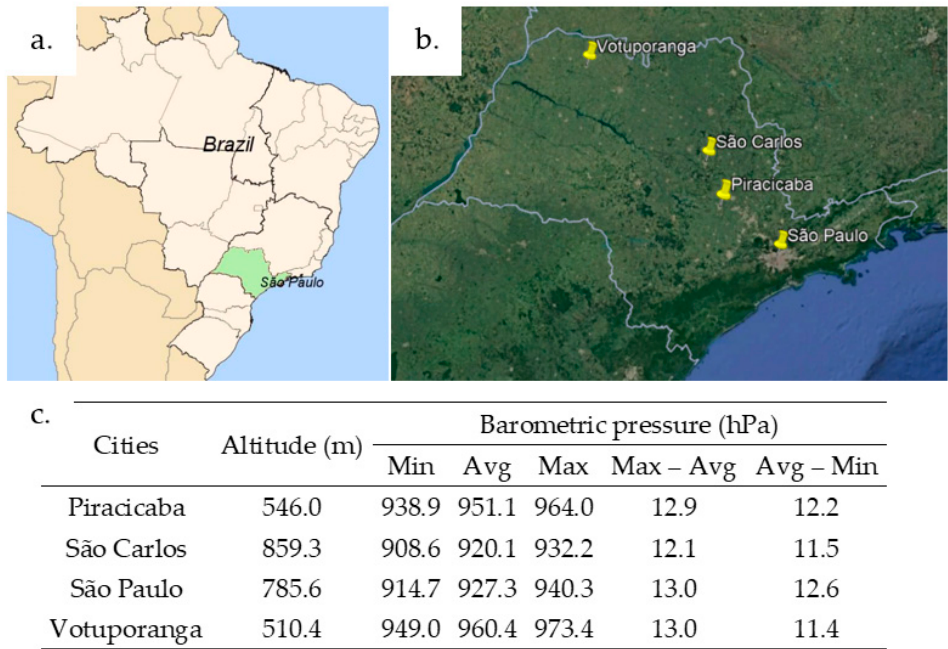
Figure 1. Minimum, average, maximum, and deviations from the average values of barometric pressure (hPa) in cities of São Paulo state, Brazil, from January 2017 to December 2021 (( a ): location of São Paulo state in Brazil; ( b ): location of the cities where barometric pressure data were analyzed; ( c ): data of barometric pressure).